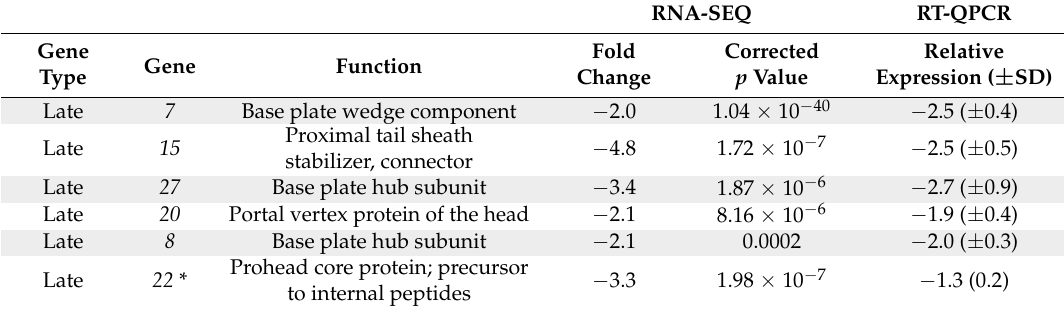
Table 1. A T4 motB knock-down lowers some T4 late gene expression at 5 min post-infection. RNA-seq was performed for three independent T4 wt and T4 motB am infections of NapIV NS E. coli. Differential expression was determined using the Baggerley’s Test in CLC Genomics Workbench with FDR corrected p values. Genes with ≥ 2-fold decreasing expression and a p value ≤ 0.05 are listed. For RT-qPCR, genes